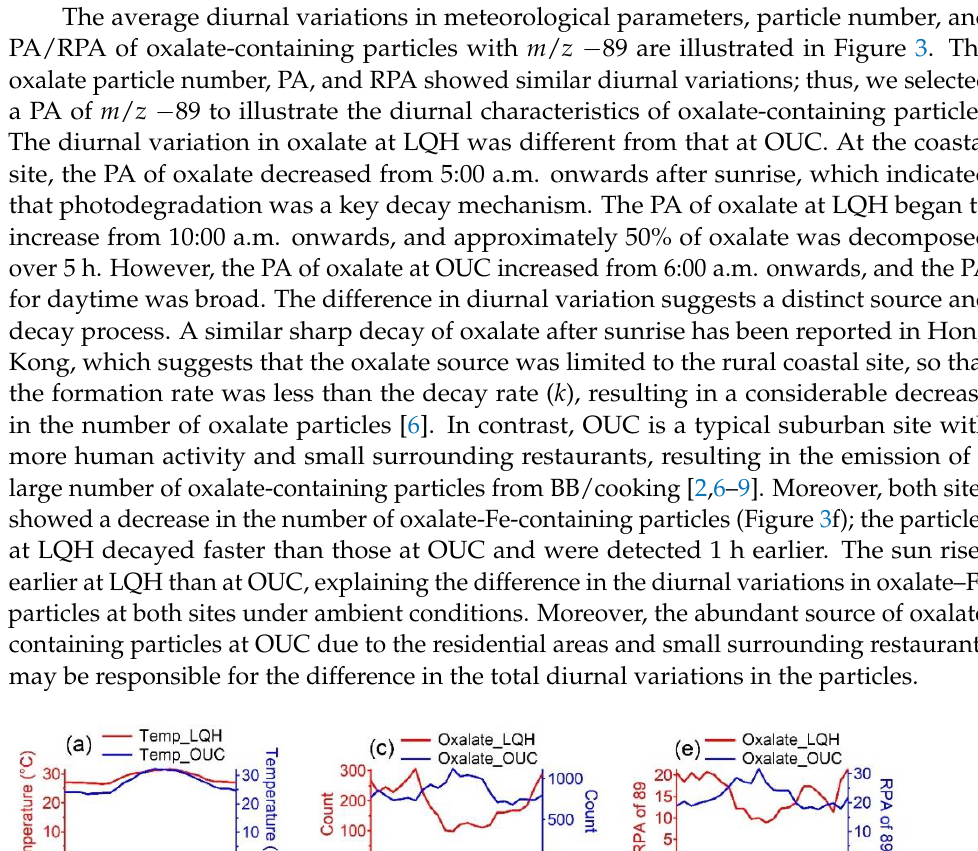
Figure 2. Time trends of meteorological factors, the relative particle number of oxalate-containing particles, and the contribution of each group to the total oxalate particles (by number) at ( a ) LQH and ( b ) OUC.